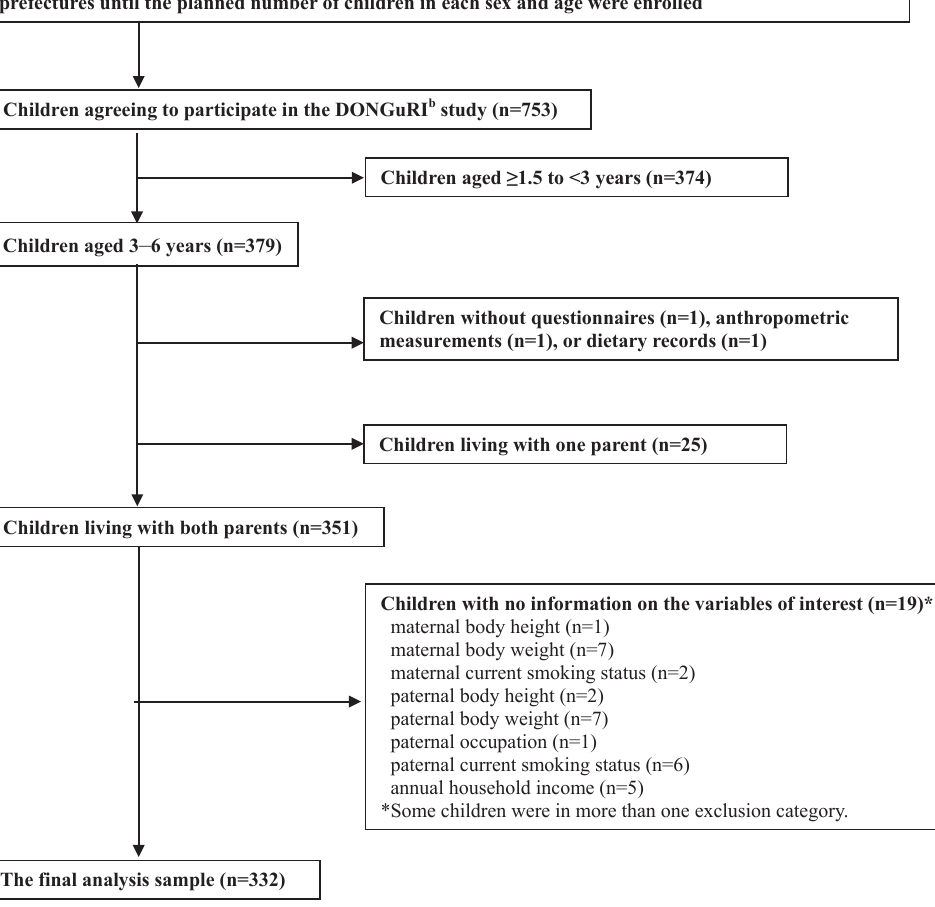
Figure 1. Eligibility for and participation in the present analysis (DONGuRI b study). a Two boys and two girls aged 3, 4, 5, and 6 year as well as eight boys and eight girls aged ; 1.5 to < 3 years in each prefecture. b DONGuRI: Dietary Observation and Nutrient intake for Good hearth Research In Japanese young